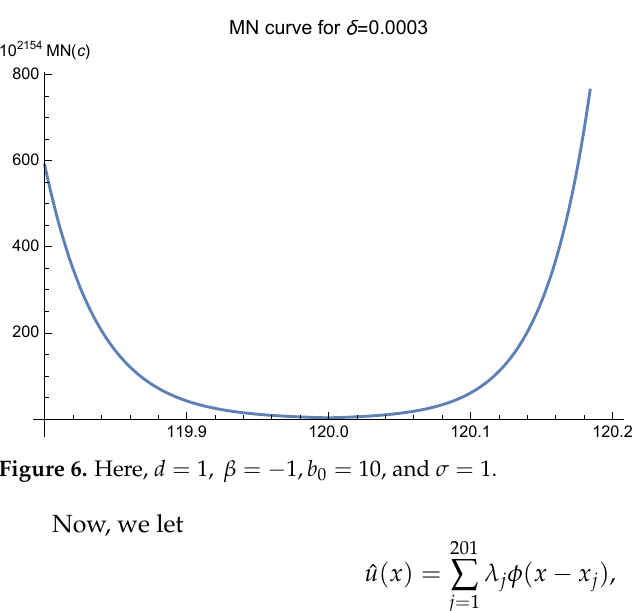
MN curve for = 0.0003 (cid:1)